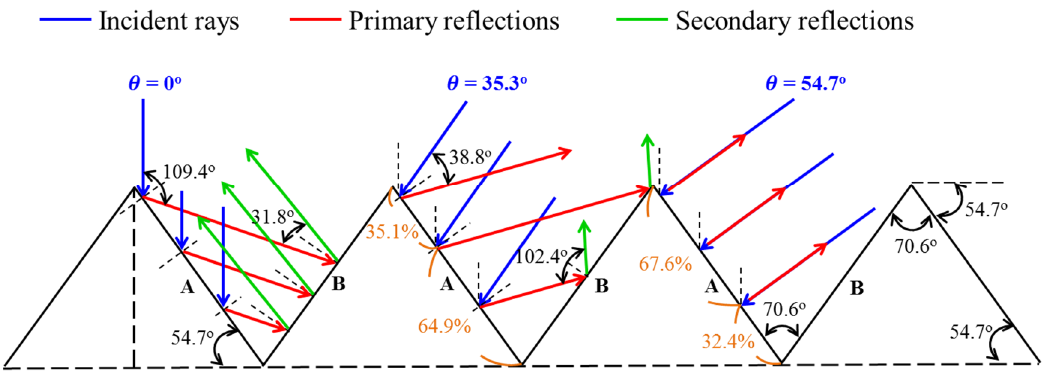
Figure 3. Schematic diagram showing the periodic pyramidal-structure.